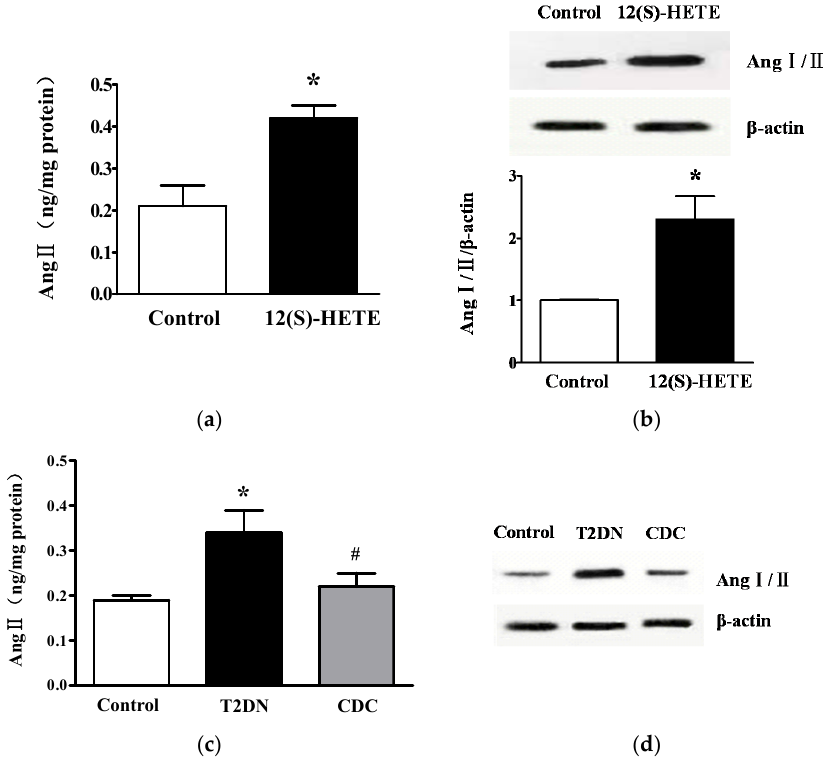
Figure 4. Effect of 12-LO on Ang II levels in rat glomeruli. ( a ) Ang II content in glomeruli of control and 12(S)-HETE infusion rats was determined by ELISA; n = 10 in each group; ( b ) Ang I/II expression in glomeruli of control and 12(S)-HETE infusion rats was determined by Western blot; n = 10 in each group; ( c ) Ang II content in glomeruli of control, type-2 diabetic rats and CDC-treated rats was determined by ELISA; n = 20 in each group; ( d ) Ang I/II expression in glomeruli of control, type-2 diabetic rats and CDC-treated rats was determined by Western blot; n = 10 in each group. Data are presented as the mean ± SD of three independent experiments; * p < 0.01 vs. corresponding controls; # p < 0.05 vs. T2DN.